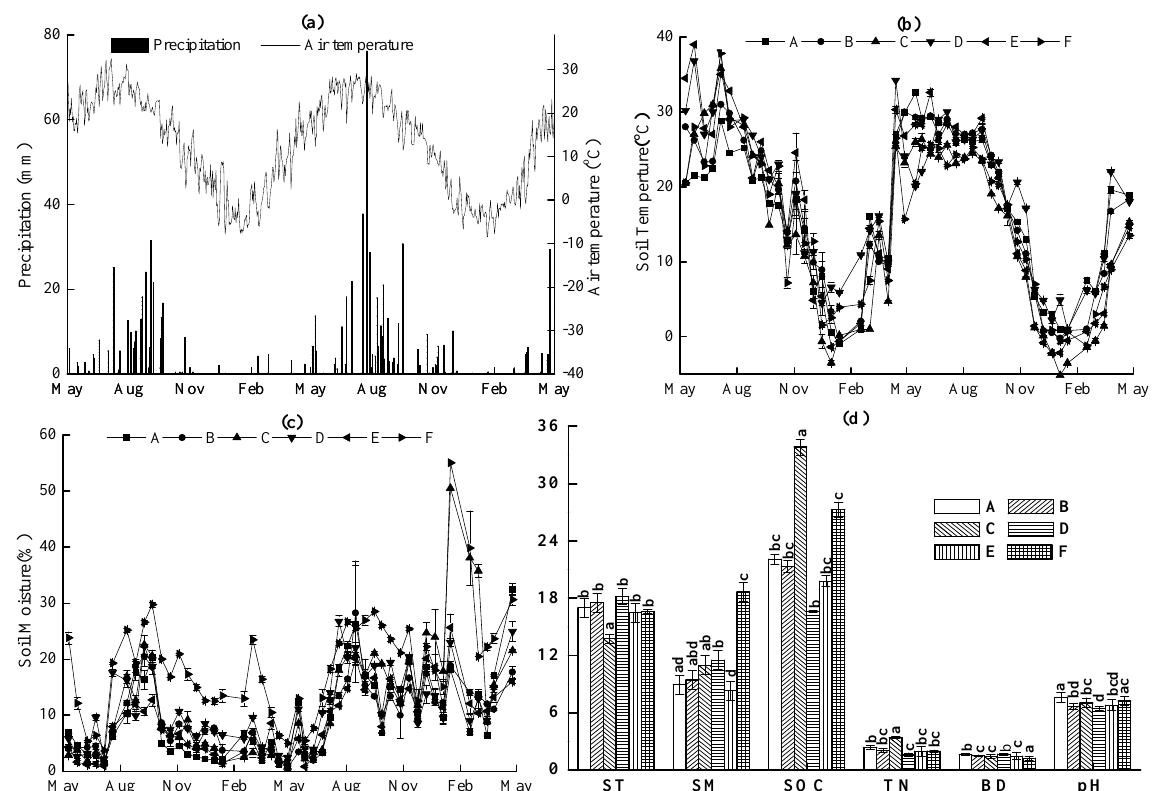
Fig. 2 Fig. 2. Seasonal patterns of daily air temperature and precipitation (a) , soil temperature at 5cm depth (b) , soil gravimetric moisture (c) , and soil properties (d) measured in six tree species on Taihang Mountain from May 2010 to April 2012. The tree species are (A) Robinia pseudoacacia , (B) Vitex negundo var. heterophylla , (C) Leptodermis oblonga , (D) Punica granatum , (E) Ziziphus jujube , and (F) Bothri- ochloa ischcemum . The error bars represent standard errors ( n = 3). ST: soil temperature ( ◦ C), SM: soil moisture (%), SOC: soil